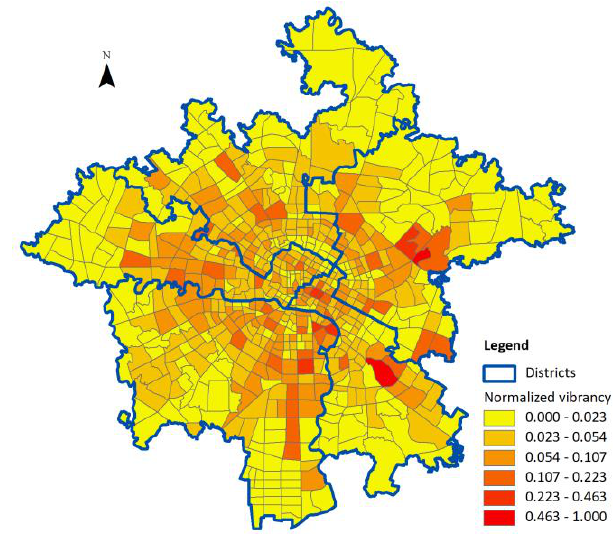
Figure 3. Spatial distribution of neighborhood vibrancy.